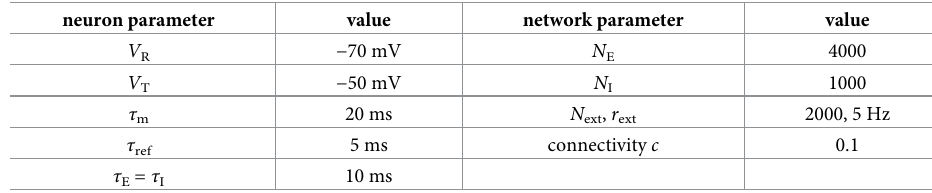
Table 3. Neuron and network parameters. neuron parameter value network